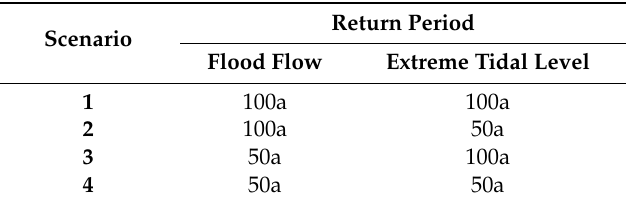
Figure 6. Locations of the 22 gauging stations in Pearl River Delta. Table 4. Scenarios employed.